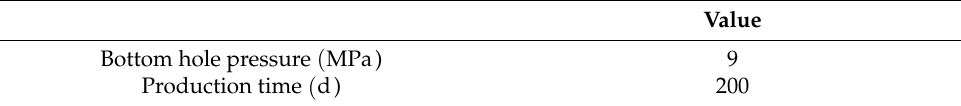
Table 10. The basic data of production.